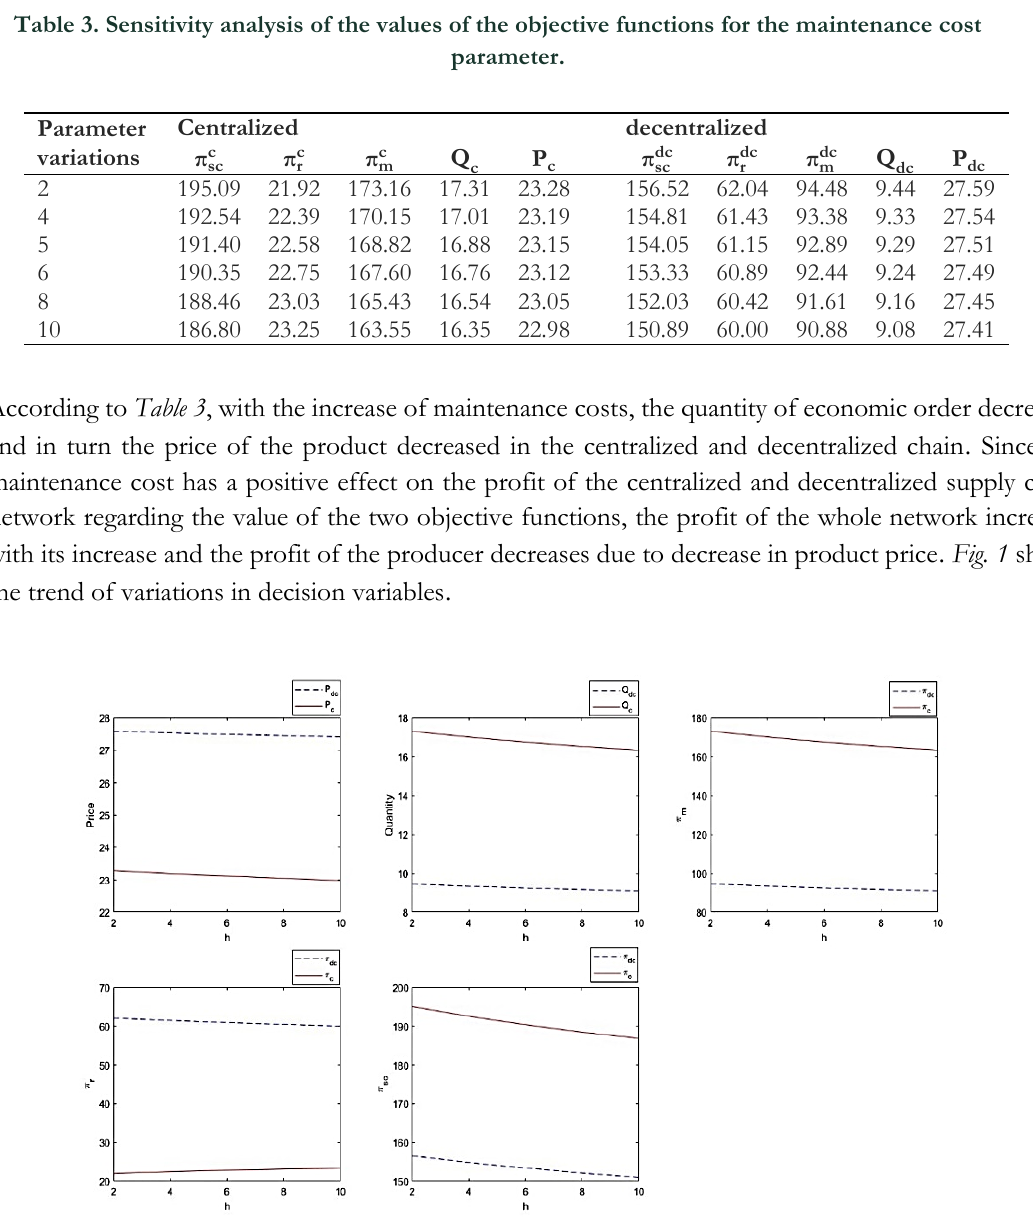
Fig. 1. The trend of variations in decision variables due to variations of maintenance costs.